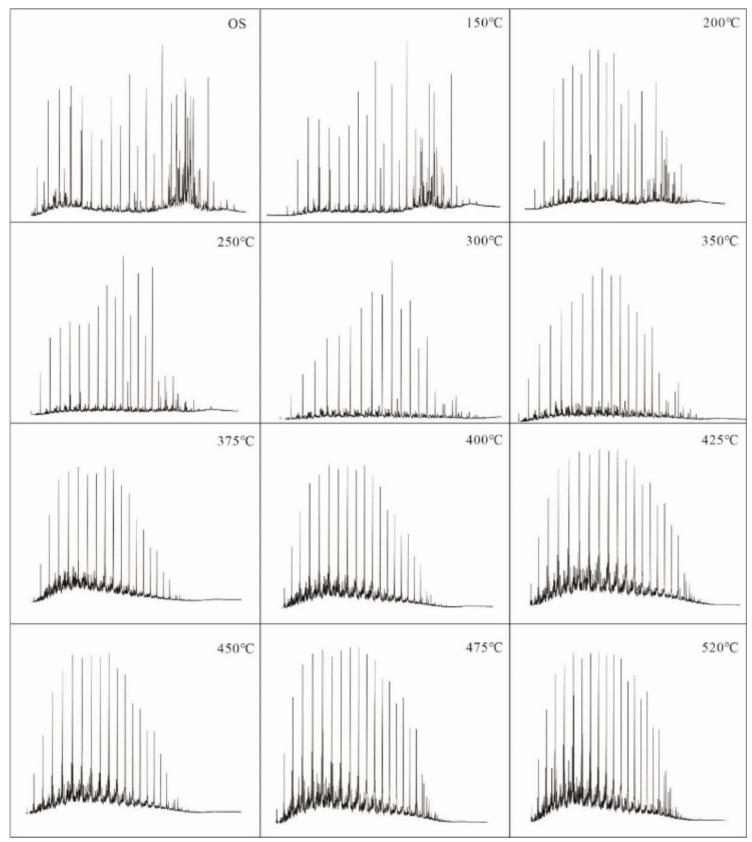
Figure 7. TIC diagrams in each